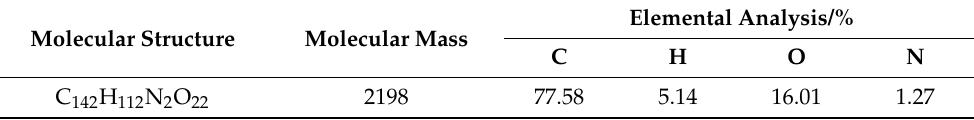
Figure 4. Two-dimensional structure ( a ) and initial 3D structural model ( b ) of Kerjian coal. Table 6. Molecular structural parameters of Kerjian coal. Table 6. Molecular structural parameters of Kerjian coal.